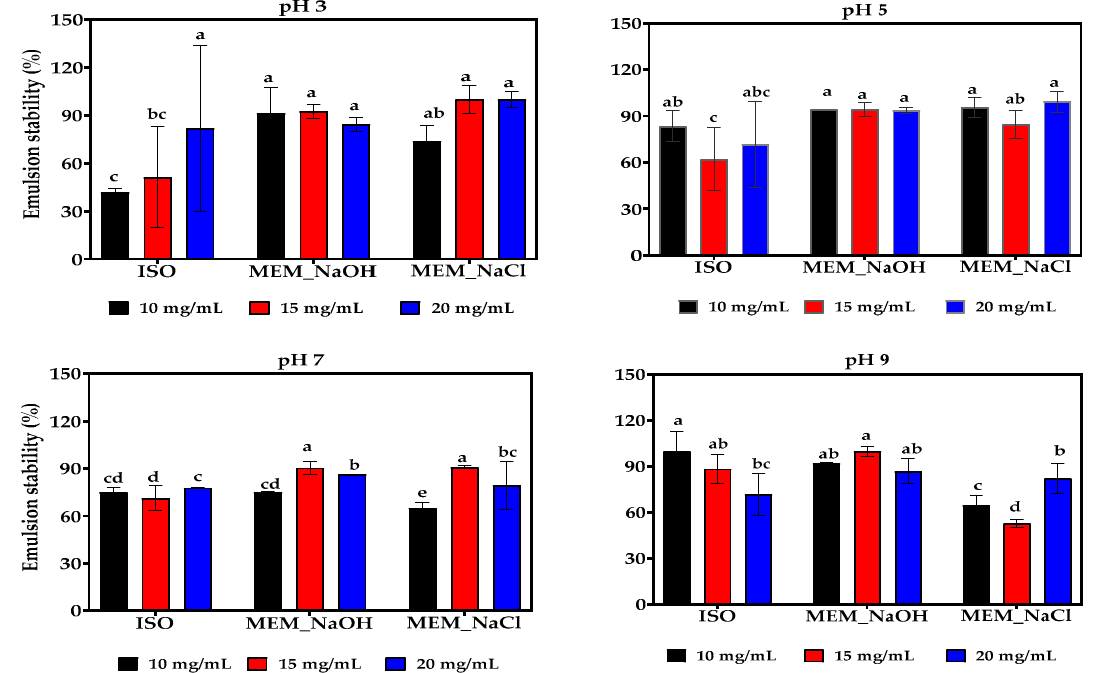
Figure 8. Effect of pH and protein concentration on the stability of emulsions produced with isoelectric pH precipitated isolate (ISO) and membrane isolated proteins from alkaline (MEM_NaOH) and salt (MEM_NaCl) solution extracts. At each pH, bars with different letters have significantly different ( p < 0.05) mean values.